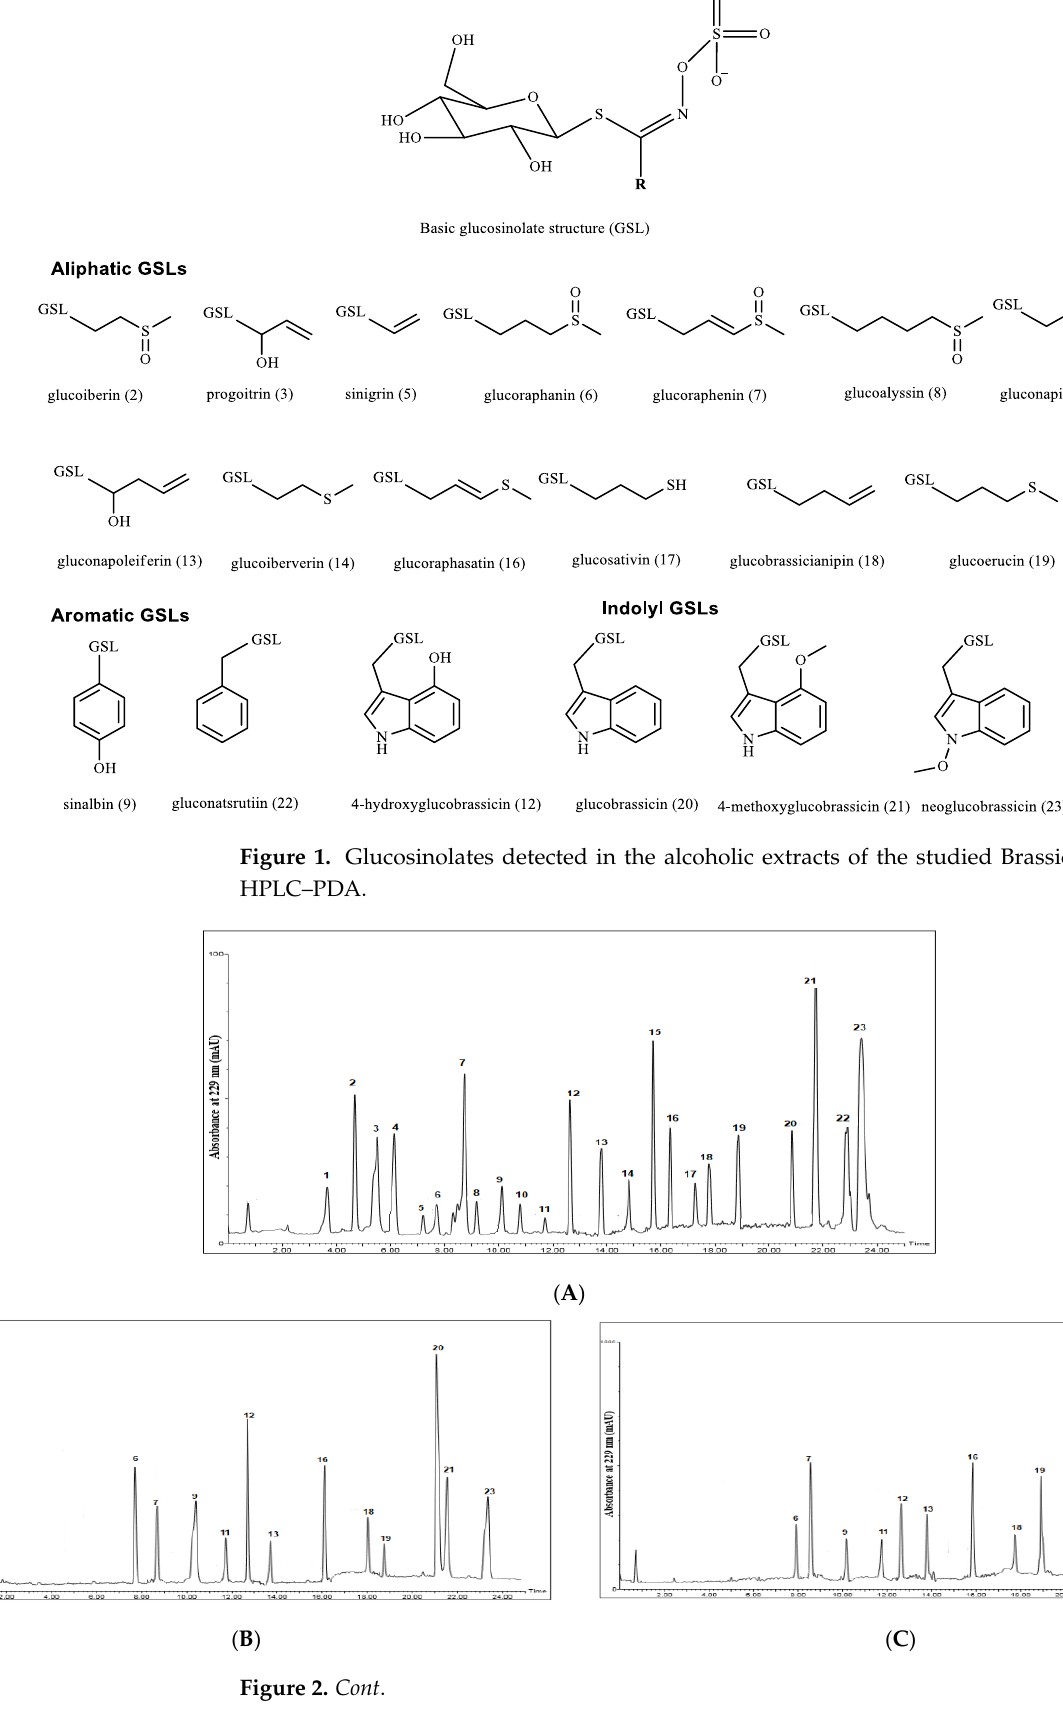
( G ) Figure 2. Chromatograms of desulfoglucosinolates in the standard glucosinolate mixture ( A ) and the alcoholic extracts of the tested seeds. ( B ) Raphanus raphanistrum L. ( C ) Raphanus sativus L . ( D ) Brassica oleracea var. botrytis L. ( E ) Brassica oleracea var. capitata L. ( F ) Brassica rapa L. ( G ) Eruca sativa L. Numbers on charts indicate names of corresponding glucosinolates, which are given. .